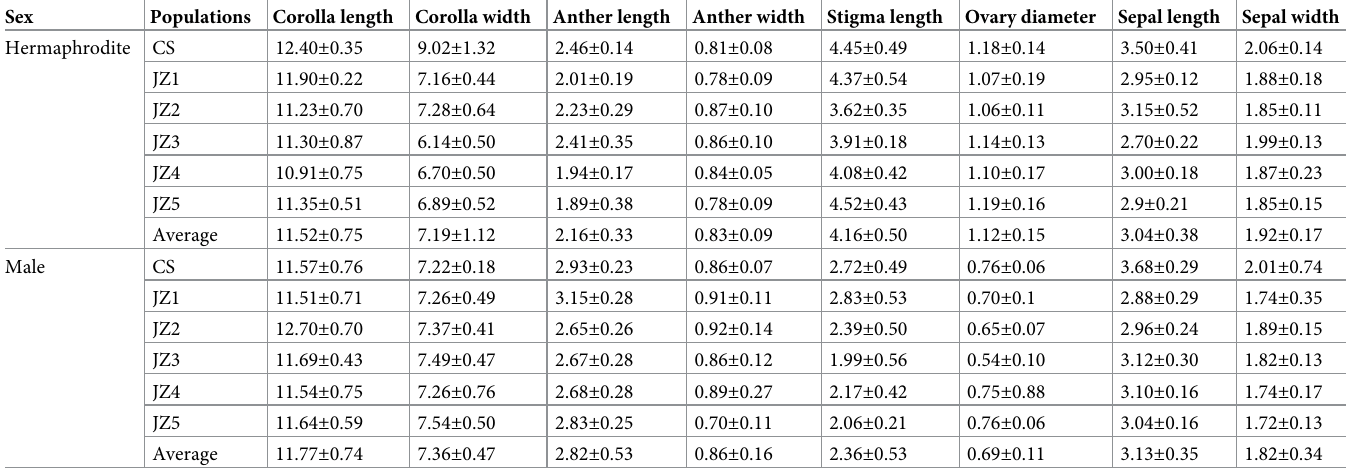
Note: 20 Flowers of each individual were randomly selected (Units: all in